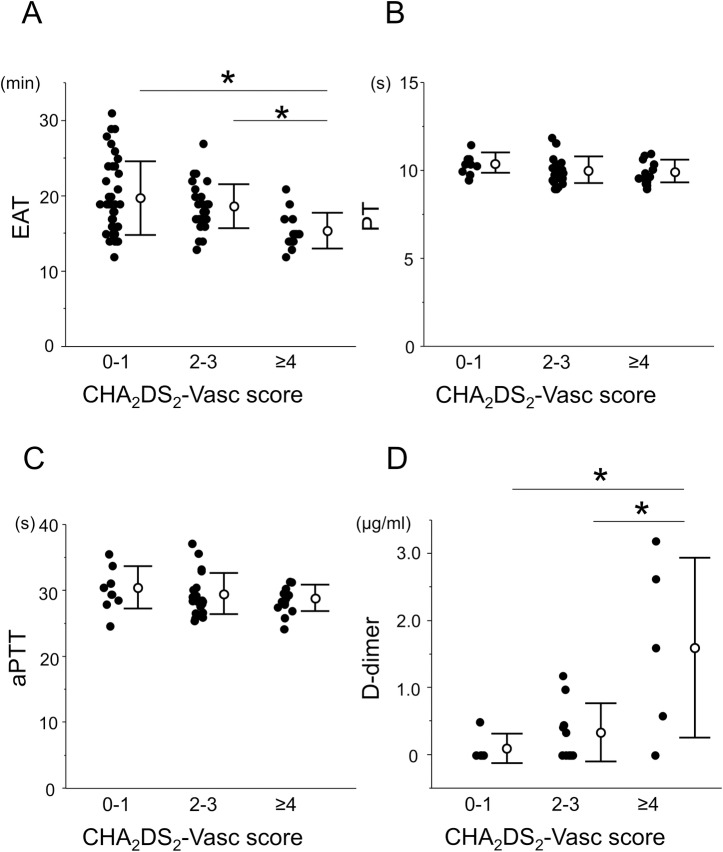
Coagulation parameters in the DBCM and conventional assays in groups with different CHA2DS2-Vasc scores.The patients were classified into 3 groups according to their CHA2DS2-Vasc score (0–1, 2–3, and ≥4) for a comparison with the EAT (A), PT (B), aPTT (C) and D-dimer (D). The EAT and D-dimer showed a significant difference by ANOVA, and multiple comparisons revealed that the CHA2DS2-Vasc score ≥4 group had a significantly shorter EAT and higher D-dimer than the other 2 groups. Neither the PT nor aPTT exhibited any difference among the 3 groups. *, p <0.05.